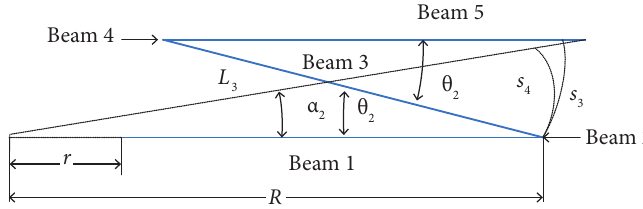
Figure 6. The corresponding arc and angle diagram of the torsion beam.